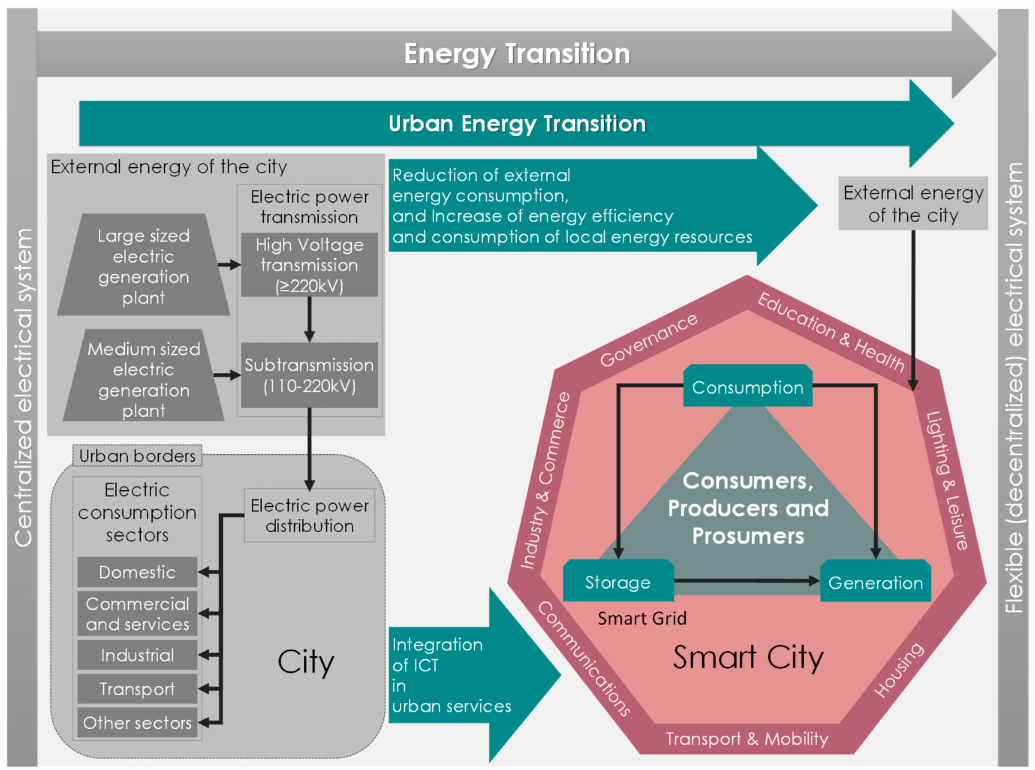
Figure 5. Decentralization of the power electric system within the smart city urban management